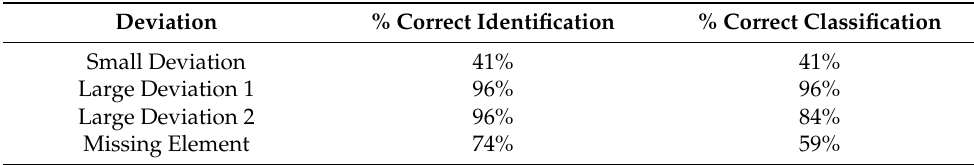
Table 3. Detection and identification rates of